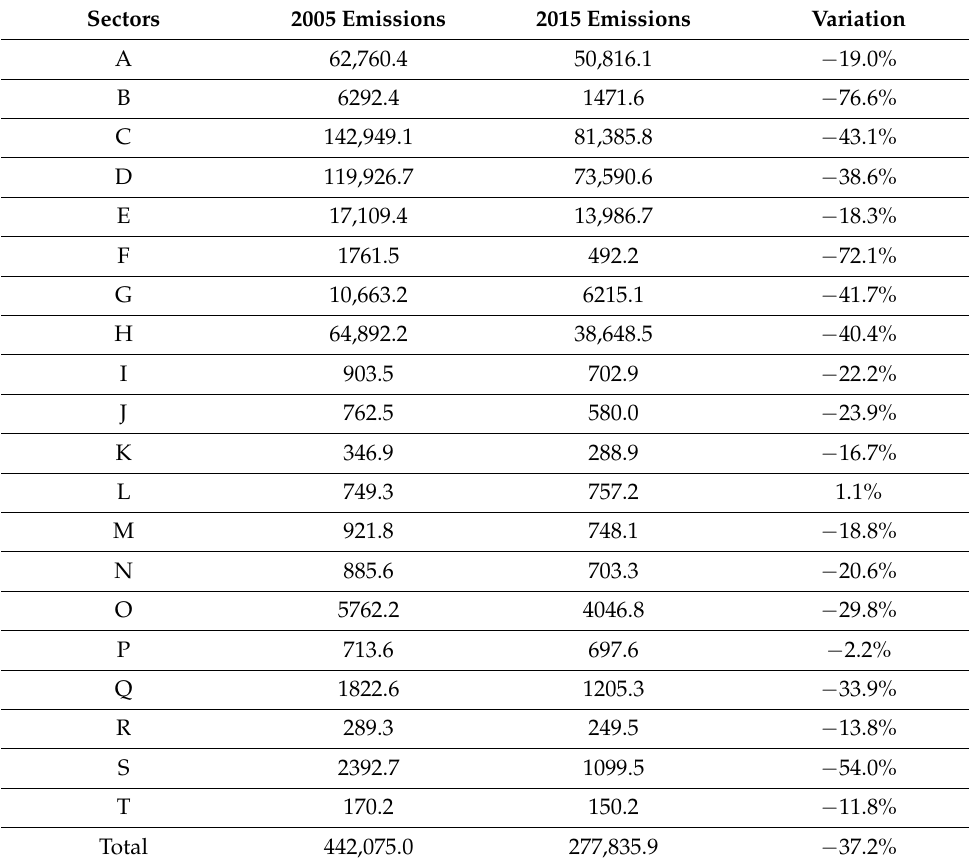
Table 3. CO 2 equivalent emissions (thousands of tons) in the period 2005–2015 and their variations